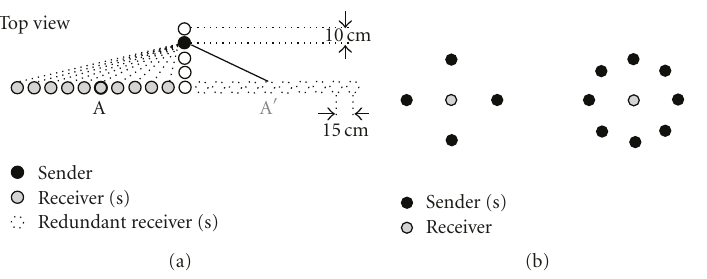
Figure 3: WUSN testbed layouts for UG2UG communication: (a) The layout used to investigate the e ff ects of the internode distance and